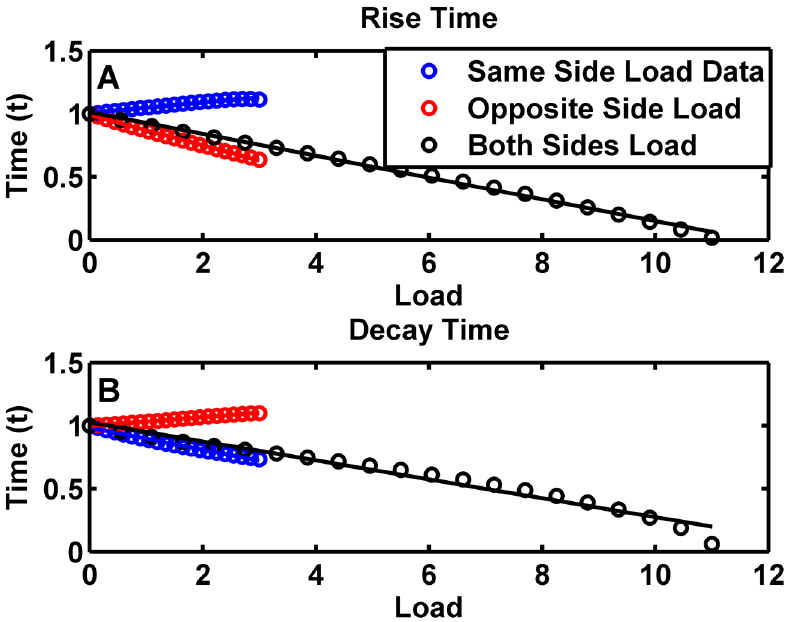
Figure 4. Effects of a load on transition times of a toggle switch without the protection assumption. (A). The time taken to reach 90% of maximum value for the protein undergoing a low-to-high transition as a function of the load. The system is de-dimensionalized as described in Supplementary Text S1 section 1.1 and 3.2.1. (B). The time taken for the concentration of the protein undergoing a high-to-low transition to reach 10% of its maximum value. Note that the linear relationship for both-sided load transition times, and same-sided decay time, and opposite-sided rise time has a negative slope. The relationship for same-sided rise time and opposite sided decay time has a very small, but positive slope.